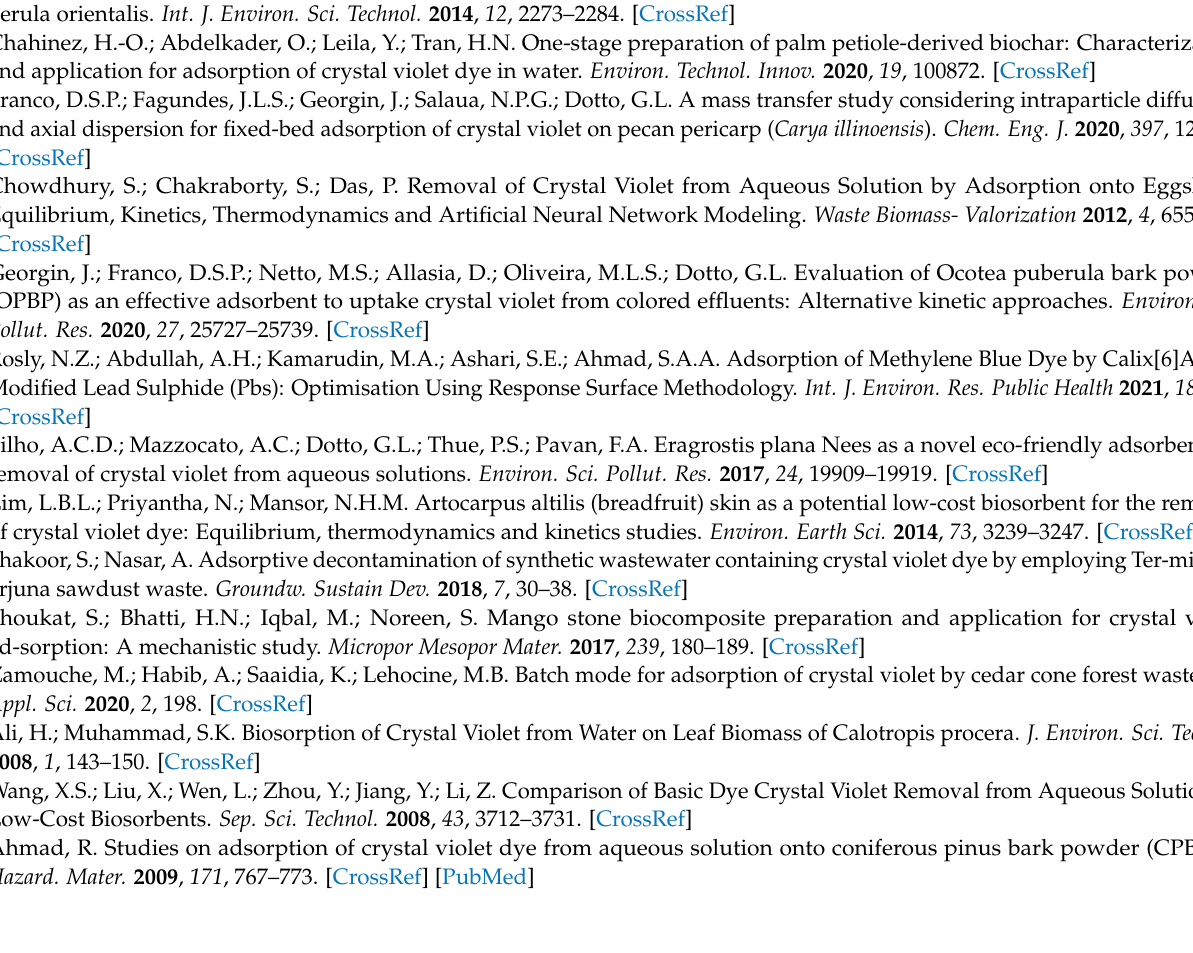
powder, Figure S2: Langmuir and Freundlich adsorption isotherms (non-linear forms) for the crystal violet adsorption onto Bathurst burr powder, Figure S3: Pseudo-first-order and pseudo-second- order kinetic models (non-linear forms) for the crystal violet adsorption onto Bathurst burr powder, Figure S4: Plot of ln K L vs. 1/T for the crystal violet adsorption onto Bathurst burr powder, Figure S5: The desorption efficiencies of crystal violet dye in different